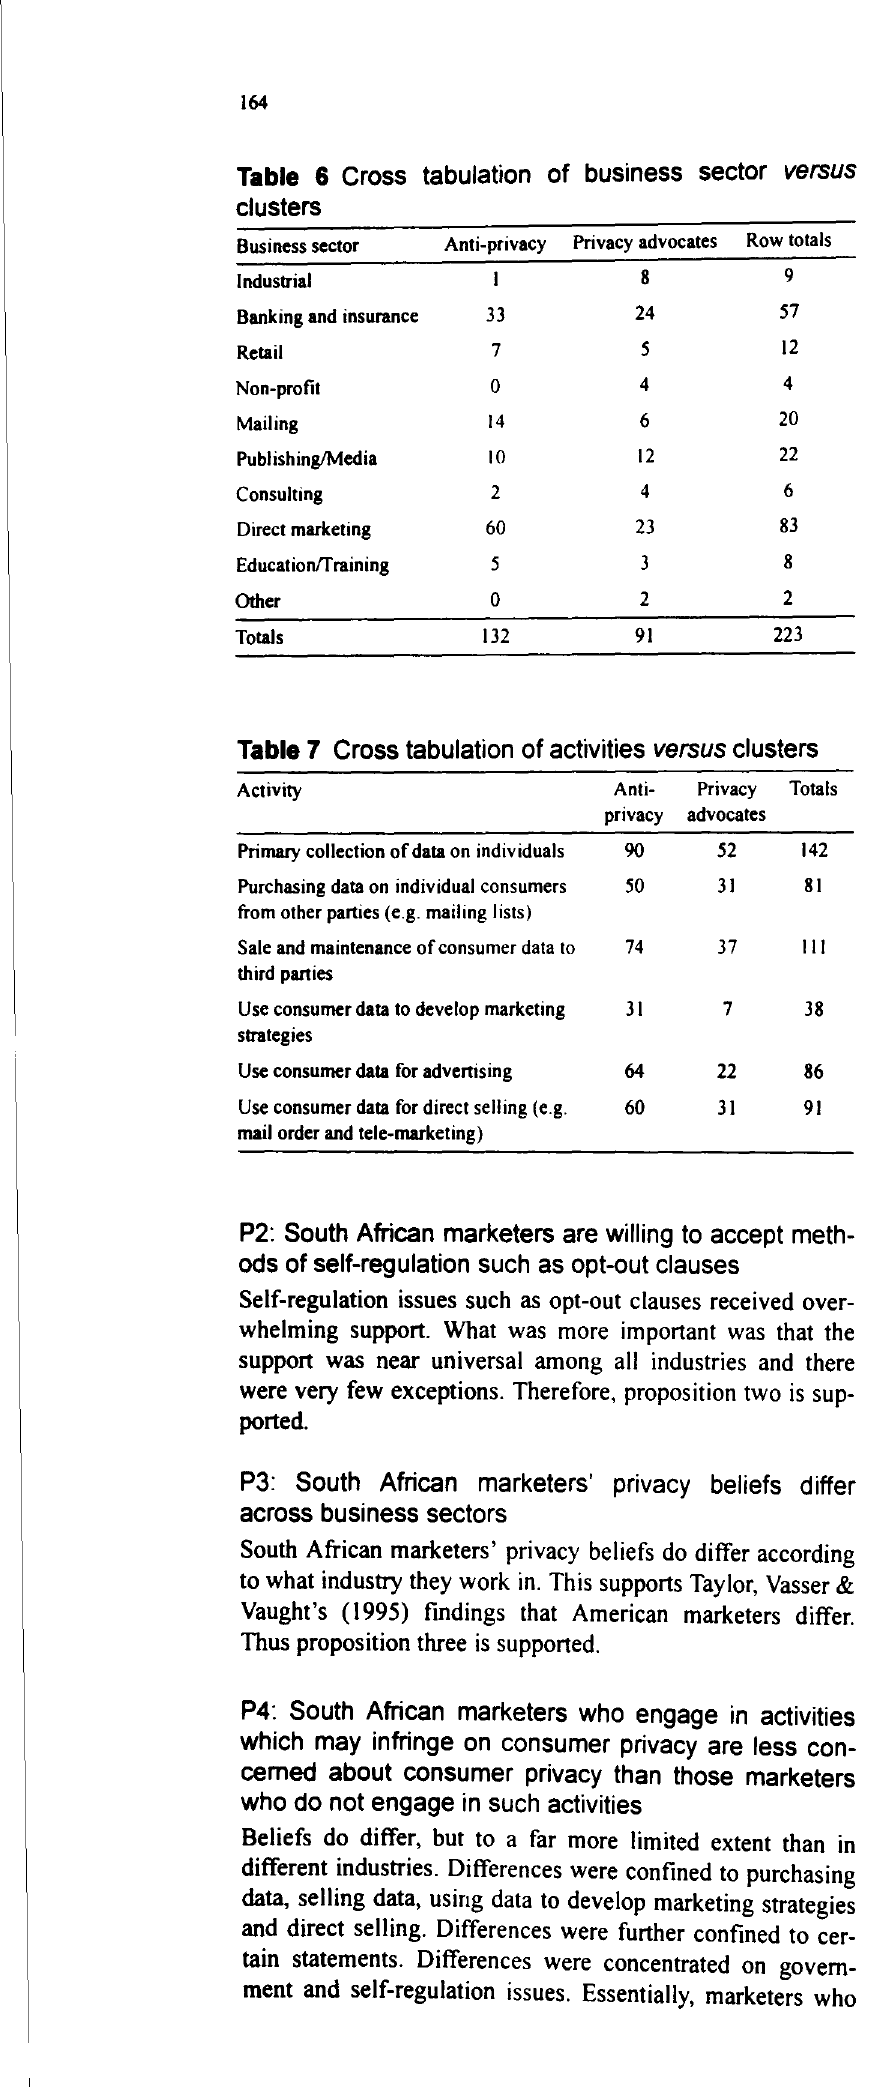
Table 6 Cross tabulation of business sector versus clusters